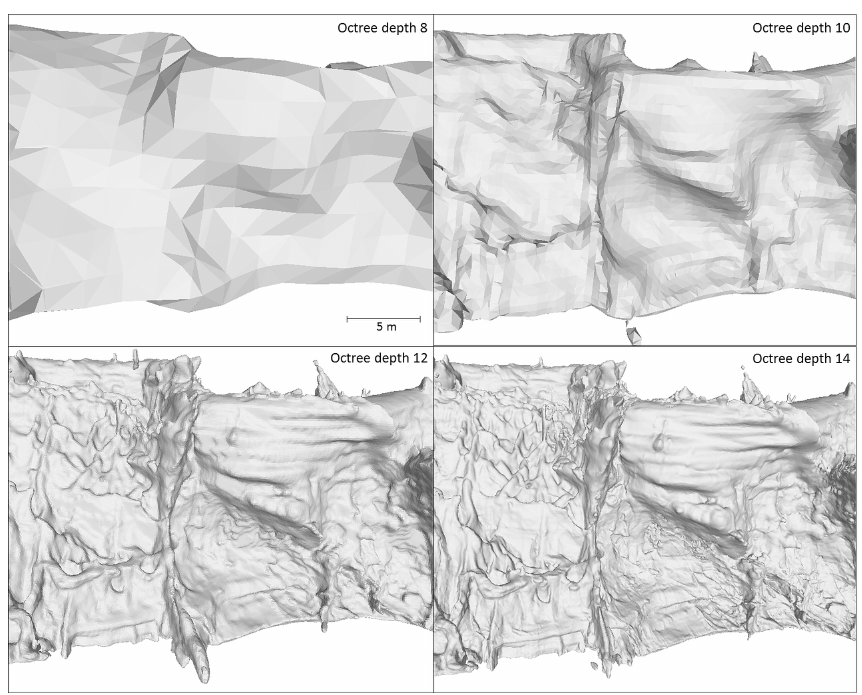
Figure 14. The level of detail for different 3-D meshes generated from the same input data with various octree depth parameter values of the Poisson surface reconstruction method. Example of the Gothic Dome using the input point cloud subsampled from the original at 5cm minimal spacing.